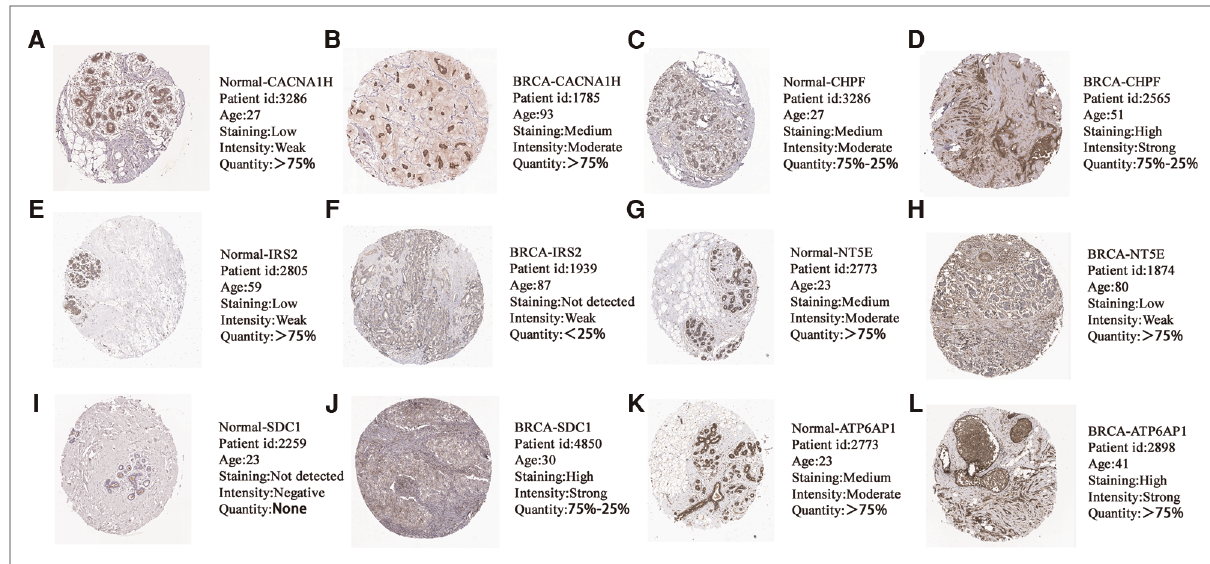
FIGURE 10 The protein expression levels of ( A,B ) CACNA1H, ( C,D ) CHPF, ( E,F ) IRS2, ( G,H ) NT5E, ( I,J ) SDC1 and ( K,L ) ATP6AP1 in HPA database based on